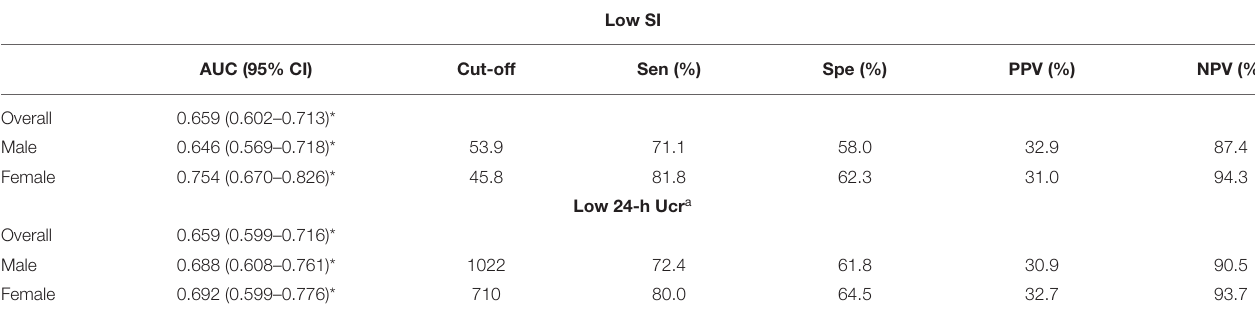
TABLE 4 | Diagnostic validity of SI and 24-h Ucr on sarcopenia, overall and stratified by